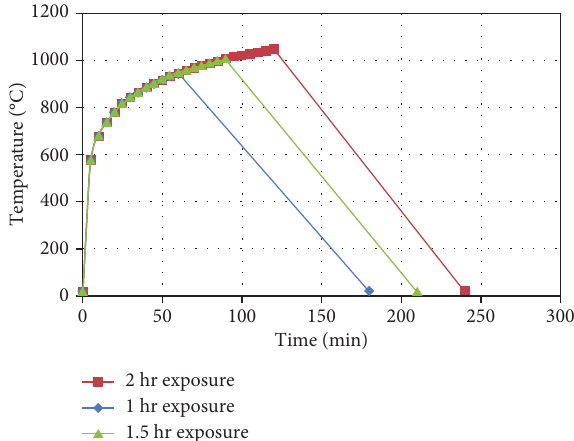
Figure 7: Fire exposure using the ISO 834 fire curve with a decay phase